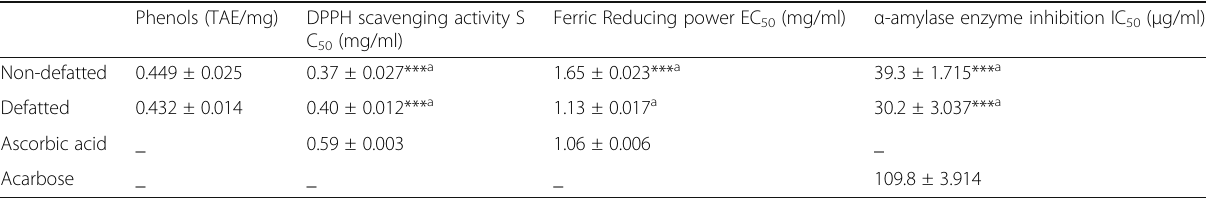
Table 2 Total phenols, antioxidants and pancreatic α -amylase enzyme inhibition